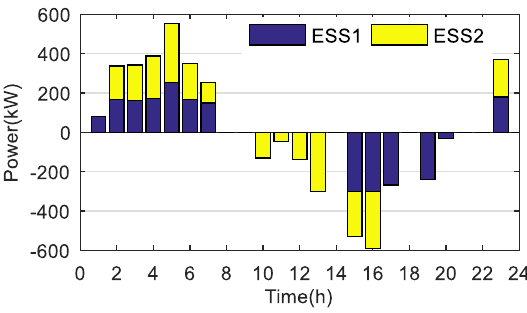
/ discharging power of energy storage system in Case Figure 7. The charging/discharging power of energy storage system in Case 2. Figure 7. The charging Figure 7. The charging/discharging power of energy storage system in Case 2.